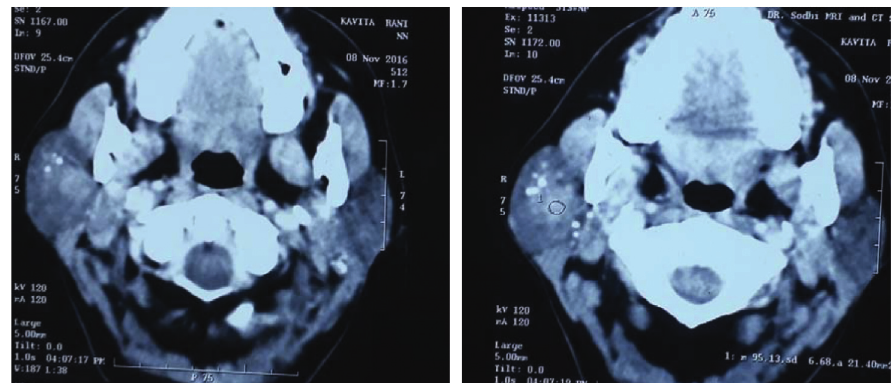
Figure 3: Axial cut contrast-enhanced computed tomogram showing a heterogeneously enhancing mass in the superficial lobe of the parotid gland with multiple pin head calcified foci in it.